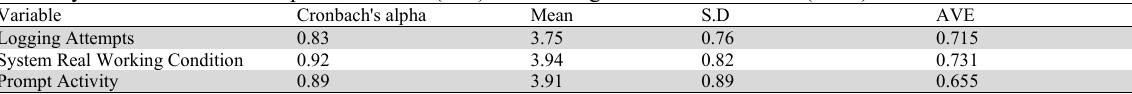
Reliability and Mean and Descriptive Statistics (S.D) and Average Variance Extracted (AVE) Variable